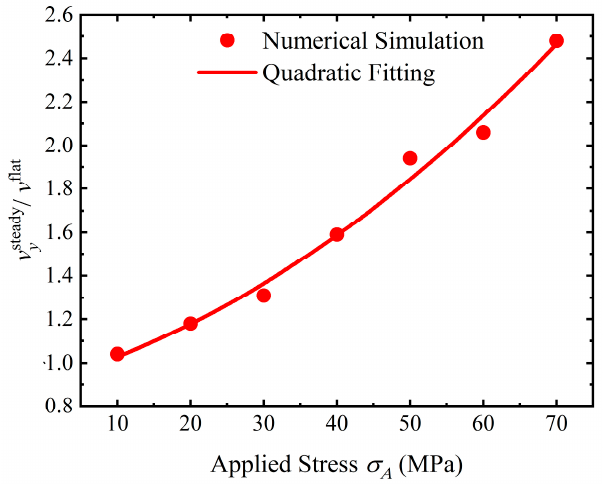
Figure 21. Corrosion acceleration ratio of the steady corrosion morphology of the flat surface steady flat v v under different applied stresses when * 0.1 A = . y v steady y / v flat under different applied stresses when A ∗ =